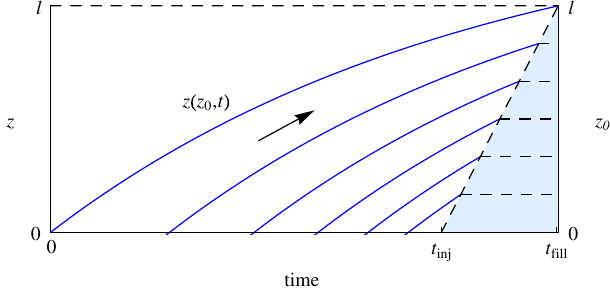
@ FIG. 1. The flow of the vector field v for the constant- k g z constant- Q linac of Sec. IV B. The curves correspond to six (cid:1) ð l (cid:1) z Þ =v (cid:3) ¼ z ; t with z ½ z . The start of values of z b 0 0 fill 0 0 . They intersect the z ¼ 0 axis at t ¼ injection is marked by t inj (cid:1) t ð z Þ . The shaded region shows the region and duration of t fill f 0 beam loading during injection. During that time the static field ð z Þ is established. The beam transit time t (cid:1) t ¼ l=v (cid:2) E is z b fill inj shown